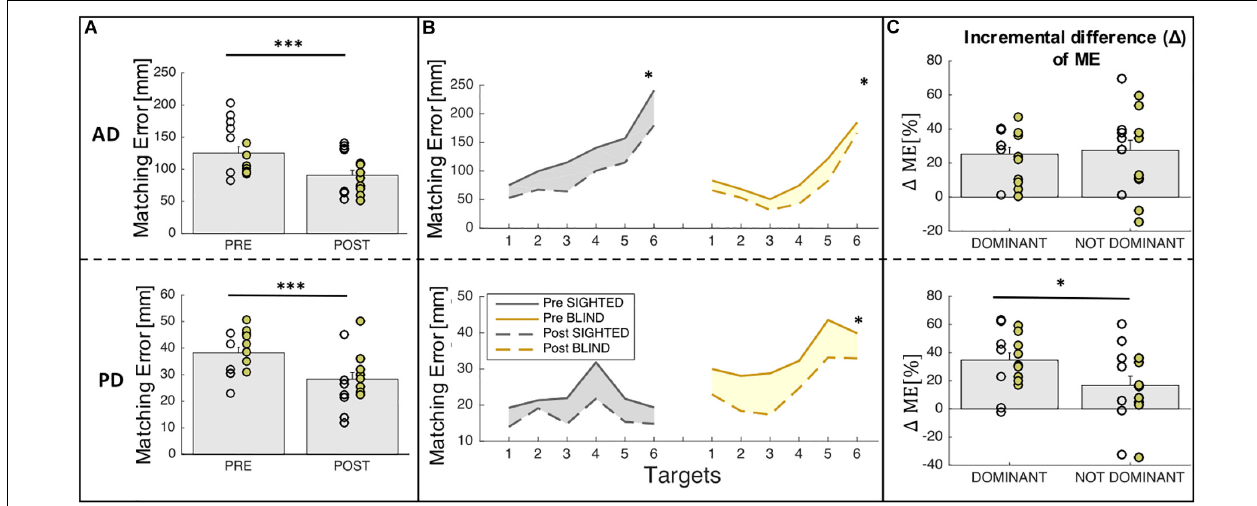
FIGURE 4 | Auditory and proprioceptive performance after the training session. (A) The panel shows the mean (bars) and individual (circles) values of ME before and after training; yellow represent blind individuals while gray represent sighted individuals. Results indicate that matching error decreases after the training both for auditory and proprioceptive domain. (B) The panel represents the auditory (top) and proprioceptive (bottom) matching errors (in mm) independently on the body side (dominant and non-dominant). Results are shown for each target location in each domain. (C) The panel represents the auditory (top) and proprioceptive (bottom) (cid:49) matching errors ( (cid:49) ME in %) for the trained (dominant) and the not trained (non-dominant) sides in both groups (sighted, blind). Results indicate that for the proprioceptive domain, participants improve their spatial performance more in the dominant side on which they performed the training. ∗∗∗ Indicates p -values < 0.001 and ∗ indicates p -values <